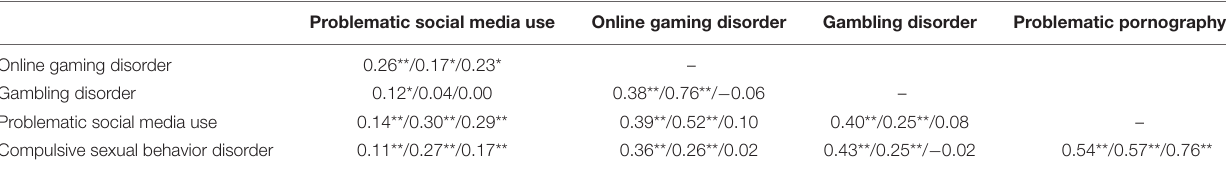
TABLE 2 | Correlations between the scales in the three data collection waves.